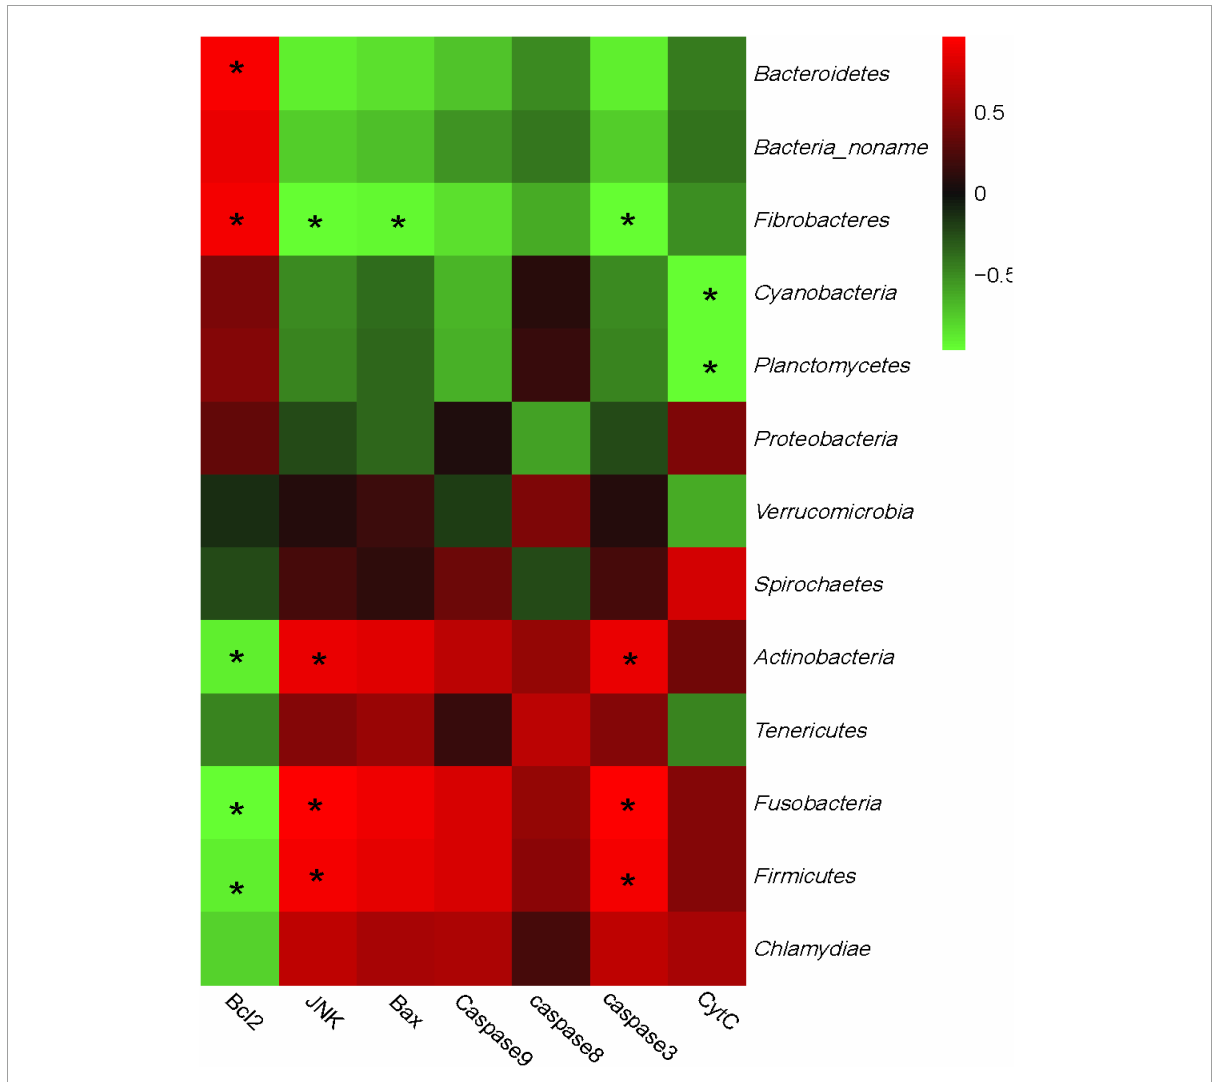
FIGURE4 Correlation analysis between rumen bacteria community and epithelial apoptosis-related genes expression. The red color represents a positive correlation while the green color represents a negative correlation. “*” means a significant correlation (| r| > 0.55, P <